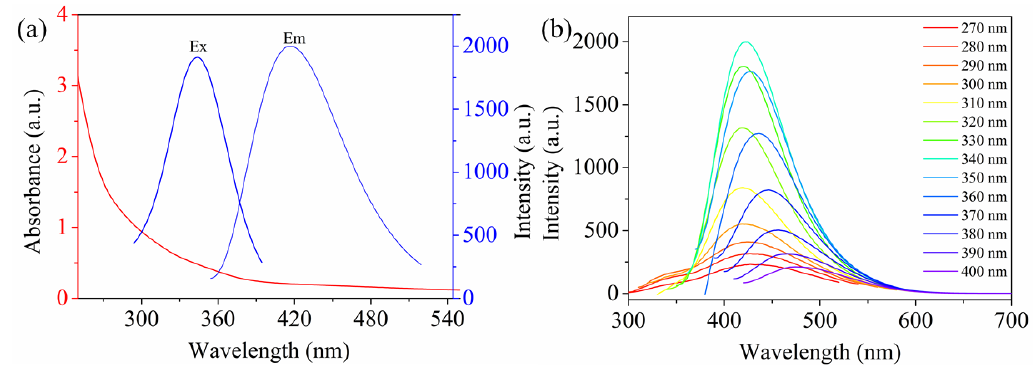
Figure 4. ( a ) Ultraviolet–visible (UV-vis) absorption and fluorescence emission spectrum of WS-MSQDs. Fig. 4. (a) UV-vis absorption and fluorescence emission spectrum of WS-MSQDs. (b) ( b ) Fluorescence emission spectra of WS-MSQDs at di ff erent excitation wavelength. Fluorescence emission spectra of WS-MSQDs at different excitation wavelength.